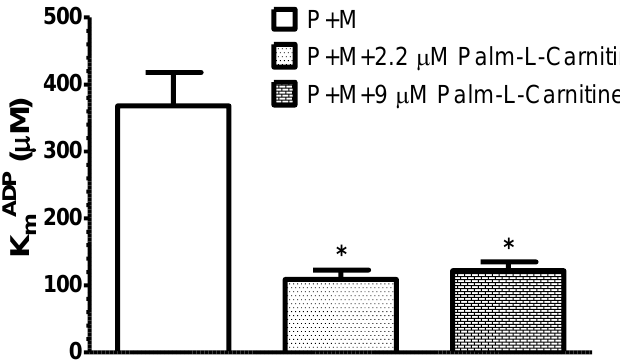
Figure 3. Influence of different respiratory substrates: pyruvate + malate (P + M, 6 mM + 6 mM), pyruvate + malate + palmitoyl- L -carnitine (6 mM + 6 mM + 2.2 µM) and pyruvate + malate + palmitoyl- L -carnitine (6 mM + 6 mM + 9 µM) on the apparent K mADP of saponin-permeabilized rat cardiac fibers. Here, n = 5; 37 ◦ C; * p < 0.05 vs. control (pyruvate + malate). The results were analyzed with one-way analysis of variance (ANOVA) followed by the Dunnett post hoc test.